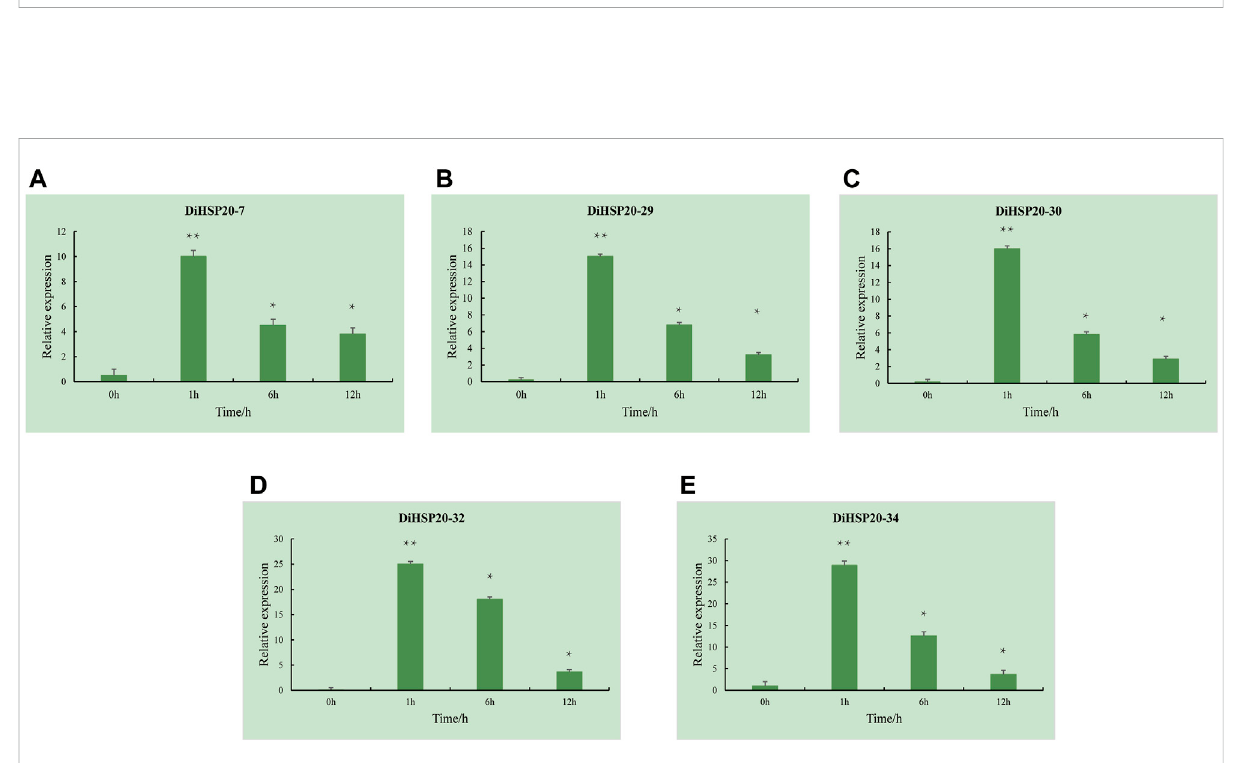
FIGURE 8 Expression pro fi les of5selected DiHSP20 genes inresponse to heat stress. Asterisk (p or pp)indicate a signi fi cant difference at p < 0.05 or 0.01, respectively.